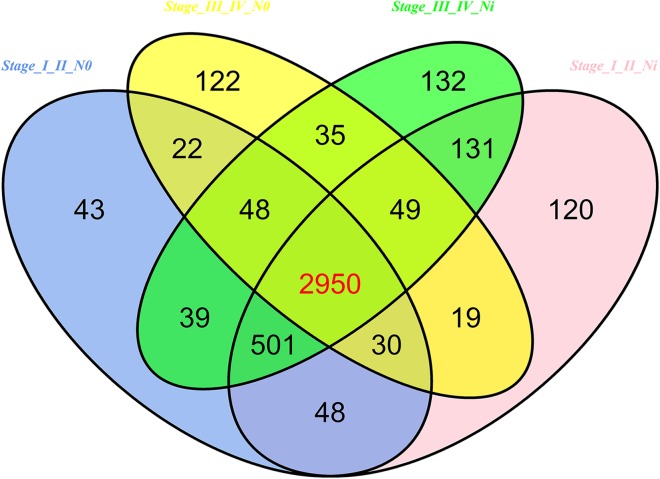
Venn diagram analysis of aberrantly expressed mRNAs between I–II Lymph/N, I–II non-Lym/N, III–IV Lymph/N and III–IV non-Lym/N.Lymph, lymphatic metastasis; non-Lym, non-lymphatic metastasis; N represents adjacent non-tumor lung tissues.